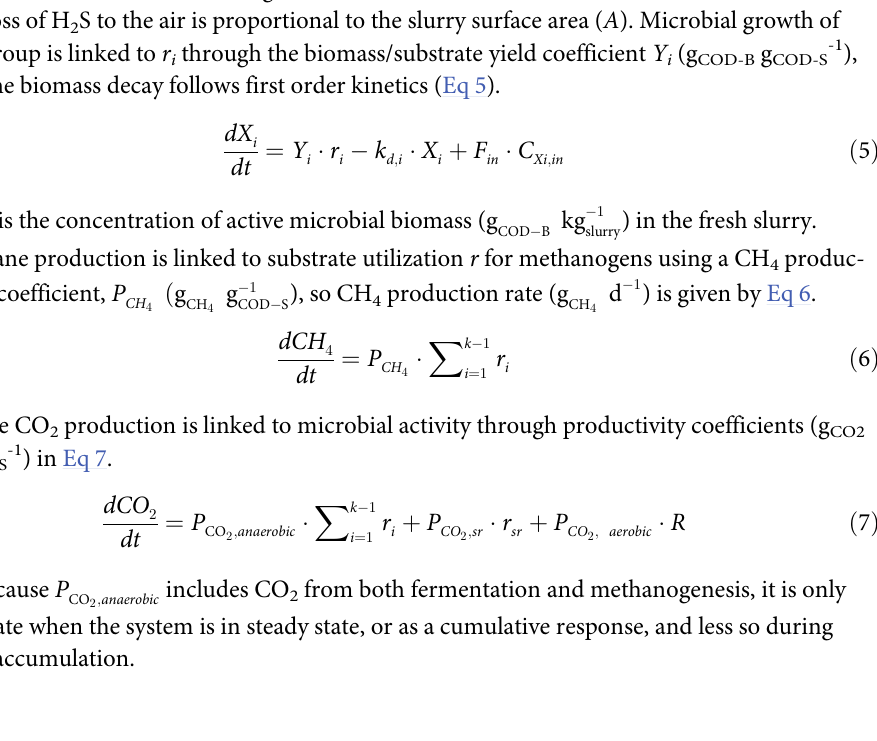
where C and K are the concentration of SO 42- ( g ) and the half-maximum kg (cid:0) 1 SO 4 S ; SO 4 slurry SO 4 (cid:0) S SO 42- saturation constant ( g ), respectively. (Note that charges on chemical species kg (cid:0) 1 slurry SO 4 (cid:0) S are omitted in subscripts for clarity in text and tables, e.g., SO for sulfate.) X represents the 4 sr biomass of active sulfate reducing bacteria. Sulfate is reduced to sulfide in a 1:1 molar ratio, and loss of H S to the air is proportional to the slurry surface area ( A ). Microbial growth of 2 any group is linked to r through the biomass/substrate yield coefficient Y (g g COD-S-1 ), COD-B i i and the biomass decay follows first order kinetics (Eq 5). dX i